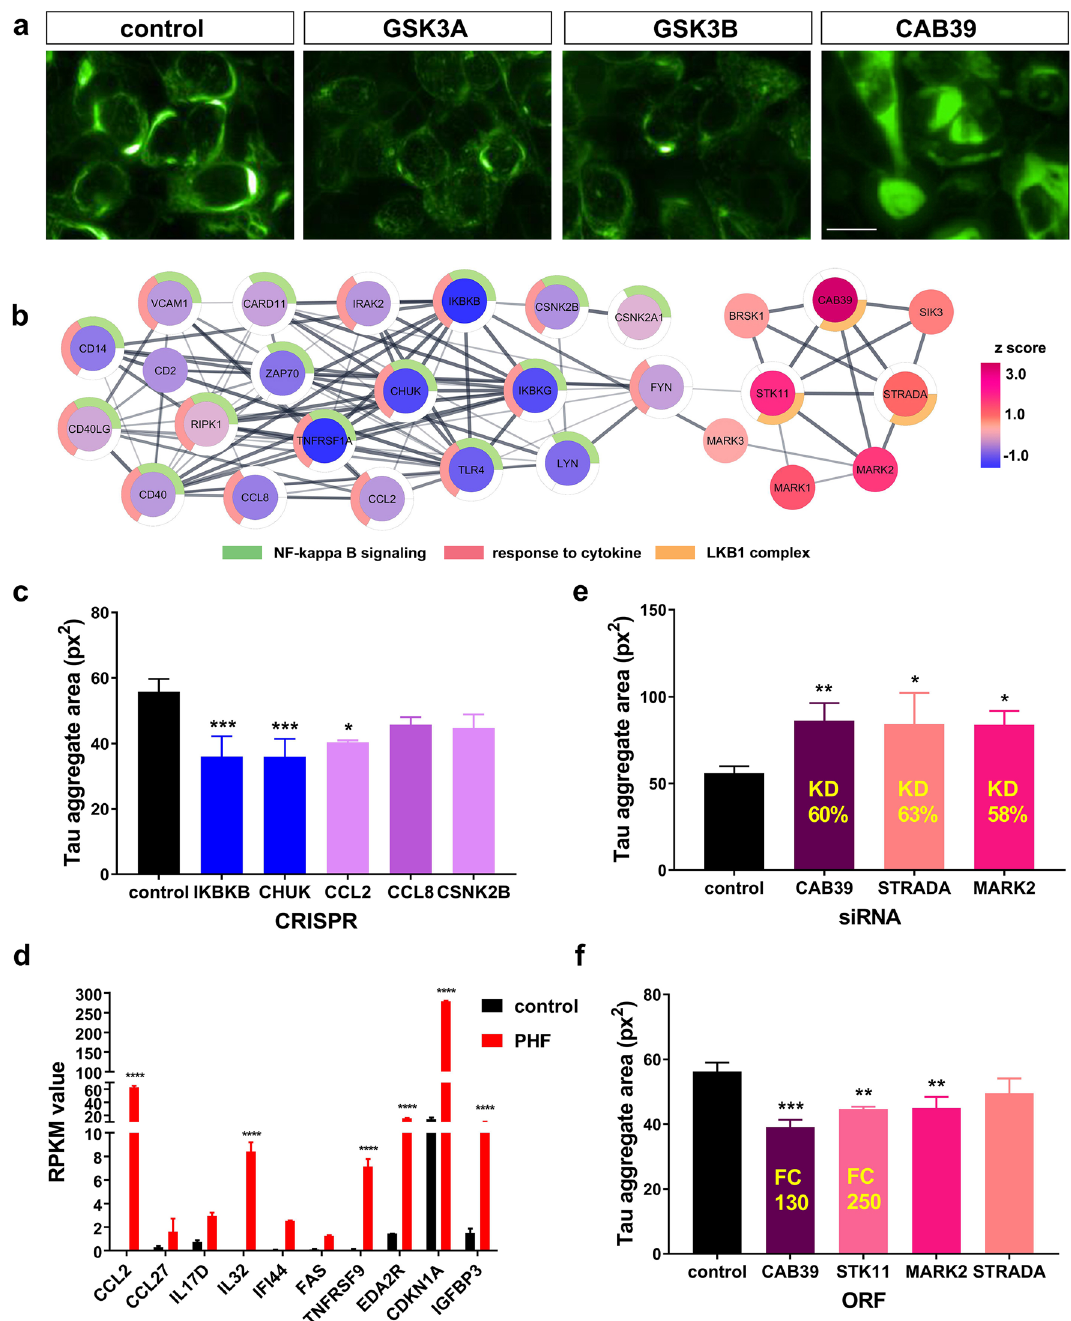
Figure 3. Discovery of interconnected network of inflammatory NF-κB pathway and LKB1 complex that modulate tau aggregation. ( a ) Tau-EGFP aggregate morphology after methanol fixation to remove soluble tau. GSK3A/B knockout decreases tau aggregate area while CAB39 knockout increases it. Scale bar = 10 μm. ( b ) Cytoscape construction of STRING network of gene sets that modulate tau aggregation, colored by aggregation area z score. Outer ring highlight network enriched pathway. STRING interaction was limited to experimental evidence and database. ( c ) Representative inflammatory and NF-κB pathway gene hits are confirmed in secondary CRISPR experiments n = 4, one-way ANOVA, F (5,12) = 9.503, p = 0.0007; Sidak’s multiple comparisons, * p = 0.014. ( d ) Tau aggregate bearing cells upregulate expression of inflammatory genes detected by RNA-seq, n = 2, Two-way ANOVA with Sidak’s multiple comparisons, F (9, 20) = 9371, p < 0.0001. ( e ) siRNA knockdown of LKB1 complex related genes repeat tau aggregation increase phenotype by CRISPR method, knockdown efficiency (KD) determined by QPCR is highlighted in yellow, n = 4, one-way ANOVA, F (3, 12) = 6.687, p = 0.0066; Sidak’s multiple comparisons, CAB39 p = 0.007, STRADA p = 0.011, MARK2 p = 0.013. ( f ) Over-expression of LKB1 complex related genes decrease Tau aggregation, further confirming primary screen finding. Over expression fold change (FC) by qPCR is indicated in yellow, n = 3, one-way ANOVA, F (4, 10) = 13.11, p = 0.0005; Sidak’s multiple comparisons, STK11 p = 0.004, MARK2 p = 0.004. All error bars indicate standard deviation, * p -value < 0.05, ** p -value < 0.01, *** p -value < 0.001, **** p -value <